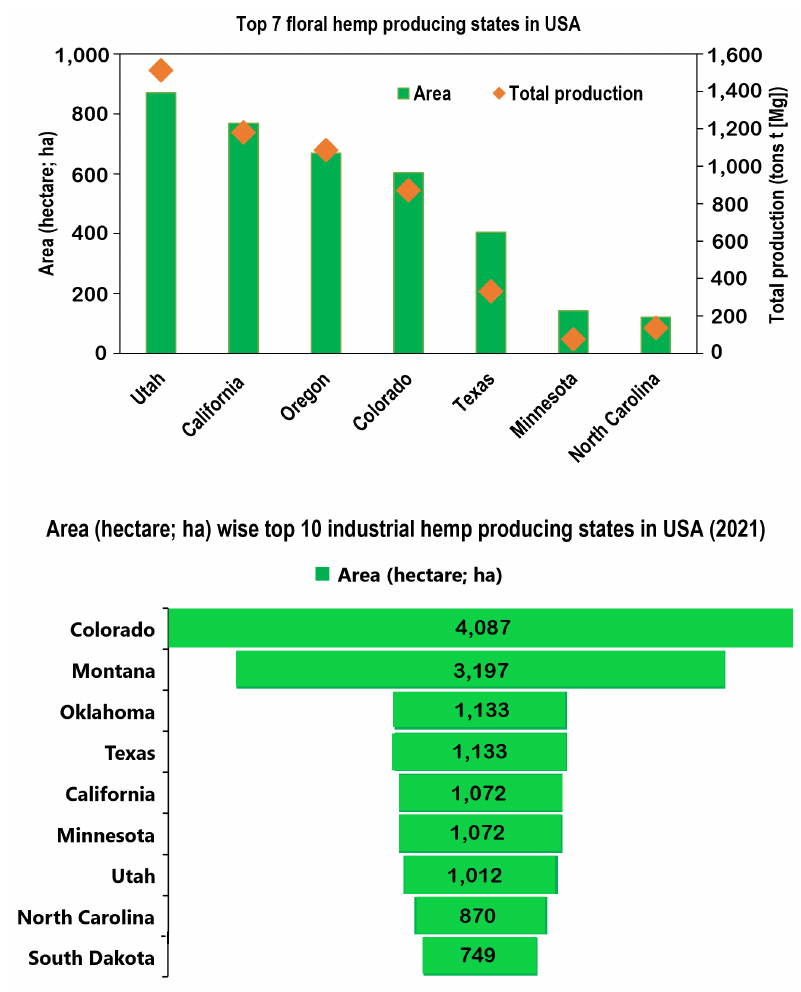
Figure 2. Area and production of the top 10 industrial and floral hemp producing states in the USA in 2021, based on data from